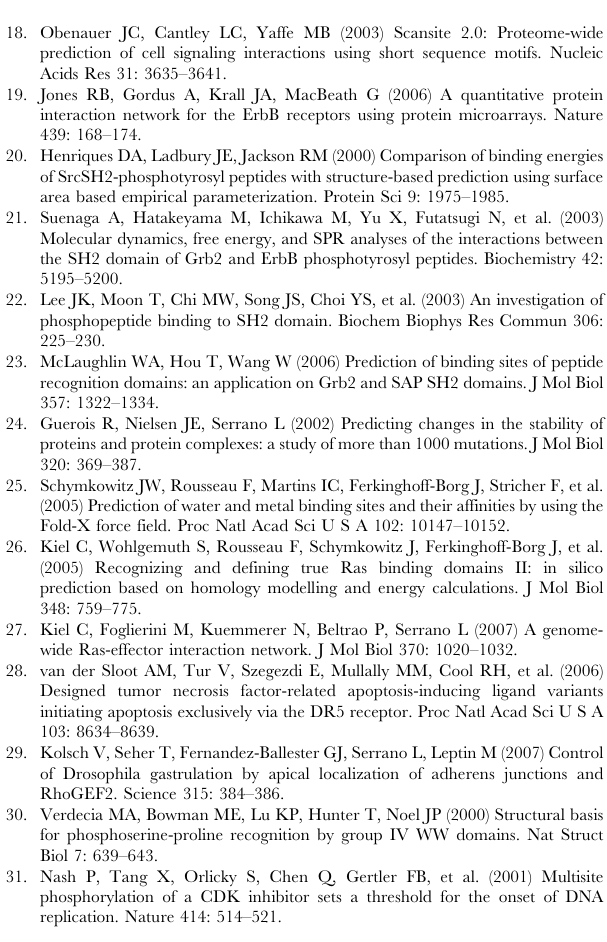
Table S3 Binding and non-binding phosphopeptides. For all SH2 domains with available x-ray structure we compiled a list of binding and non-binding peptides from the literature. We could not find significant number of known binding and non-binding peptides for the C-terminal SH2 domain of Syk.